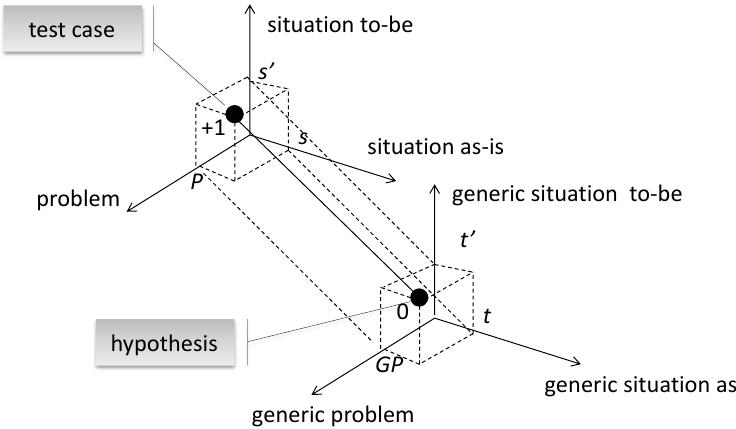
Figure 1. DS project’s two worlds: the real world and the abstract